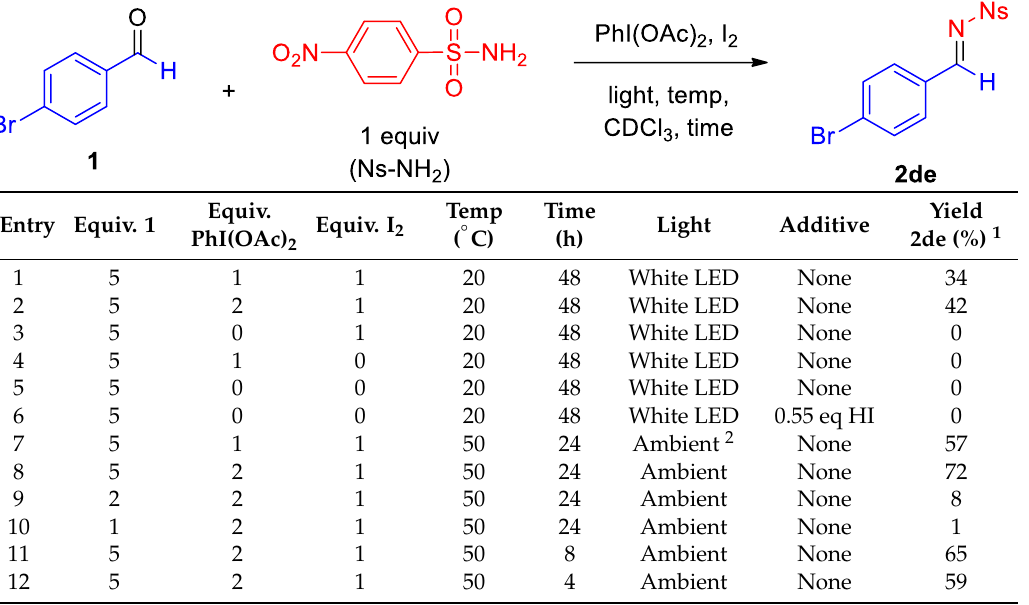
Table 1. Optimization and control reactions for the PhI(OAc) 2 /I 2 formation of N -sulfonyl imines.